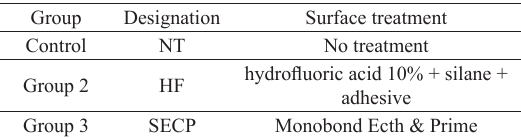
Table 2. Experimental groups, according to IPS e-max CAD CAM ceramic surface